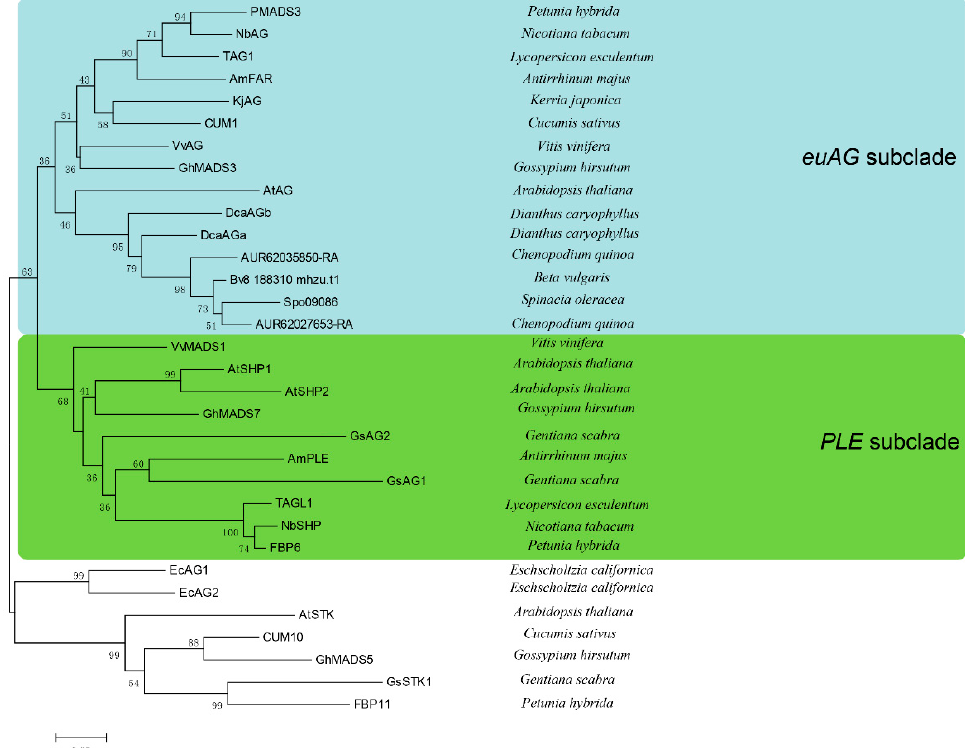
Figure 3. Phylogenetic tree showing the relationship between DcaAG genes and major C/D-class MADS-box proteins of other plants. DcaAG genes and C-class genes in Caryophyllales plants ( Beta vulgaris , Spinacia oleracea , and Chenopodium quinoa ) divide into euAG subclade rather than PLE subclade. MEGA 5.0 is used to construct phylogenetic tree, the maximum evolution method is used to infer evolutionary relationships. The phylogenetic tree is estimated by setting 2000 bootstrap replicates. The numbers below the branches refer to bootstrap value.